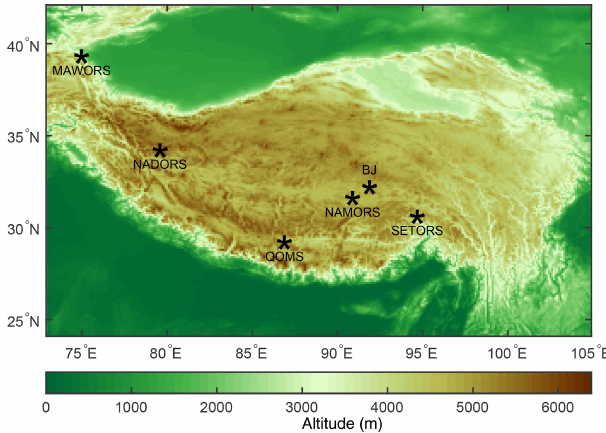
Figure 1. Locations of the six flux tower sites (marked by penta- grams) on the TP. The legend of the color map is elevation above mean sea level in